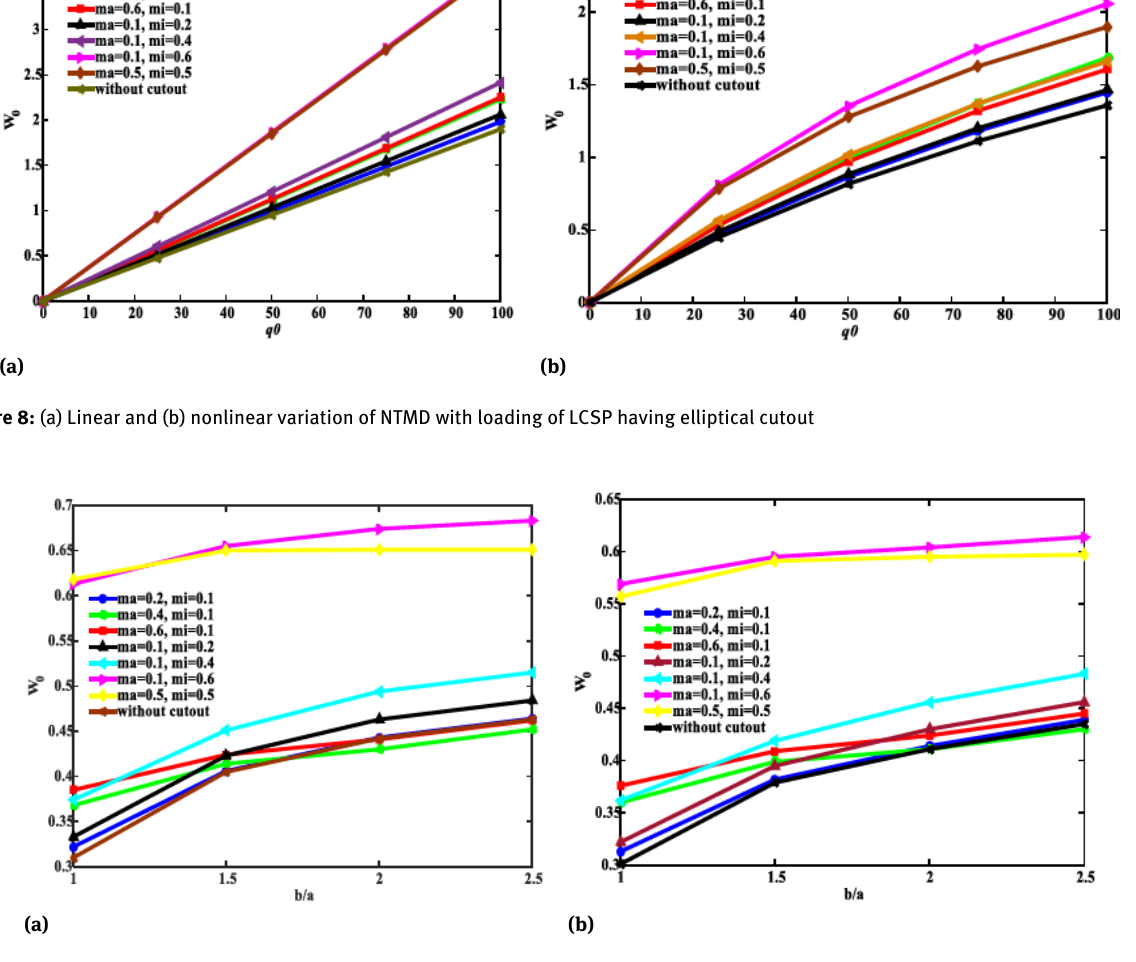
Figure 9: (a) linear and (b) nonlinear variation of NTMD with aspect ratio of plate with